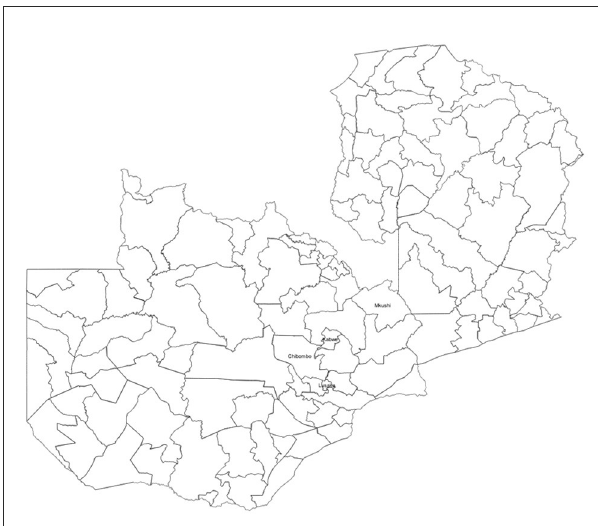
FIGURE1 District map of Zambia showing the main study areas Chibombo and Mkushi districts, respectively.